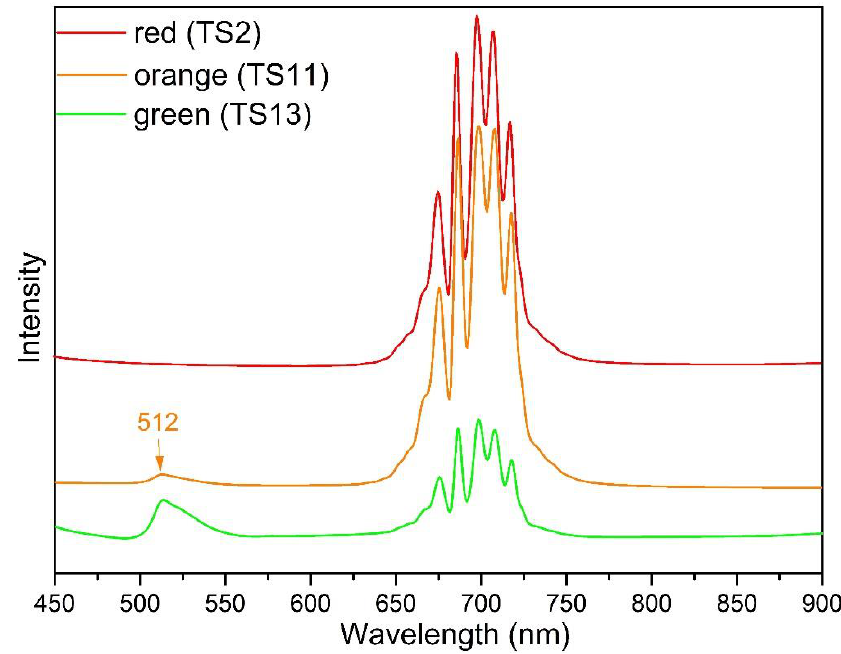
Figure 17. Fluorescence spectra of spinel samples with green, orange, and red luminescence. The peak at ~512 nm corresponds to the green luminescence. Furthermore, we compared the Cr/Mn ratio and found that the value of spinels with green fluorescence is apparently lower than that of red fluorescence ones (Figure 18). The orange fluorescence is somewhere in between, which was consistent with our hypothesis.